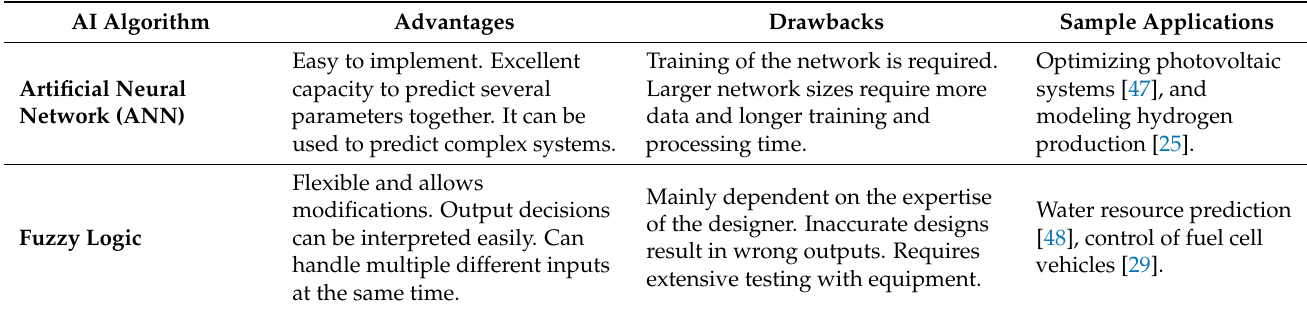
Table 1. Summary and comparison between various AI